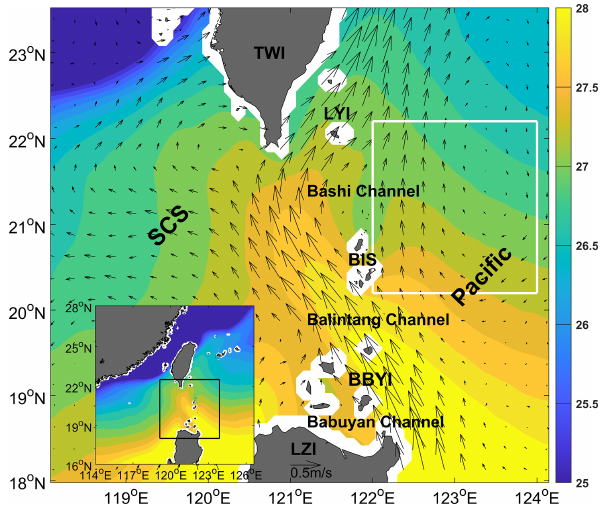
Figure 1. Climate state of spatial distribution of remote sensing systems (RSS, 2022) SST ( ◦ C; shading) and CMEMS geostrophic current (ms − 1 ; vectors) from 2003 to 2020. SCS, South China Sea; BIS, Batanes Islands; TWI, Taiwan Island; LZI, Luzon Is- land; BBYI, Babuyan Islands; LYI, Lanyu Island. White box bor- ders 20.2–22.2 ◦ N, 122–124 ◦ E. Extent of the main map is shown as black-bordered box in